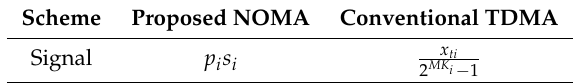
Table 2. The transmitted signal of the two schemes.